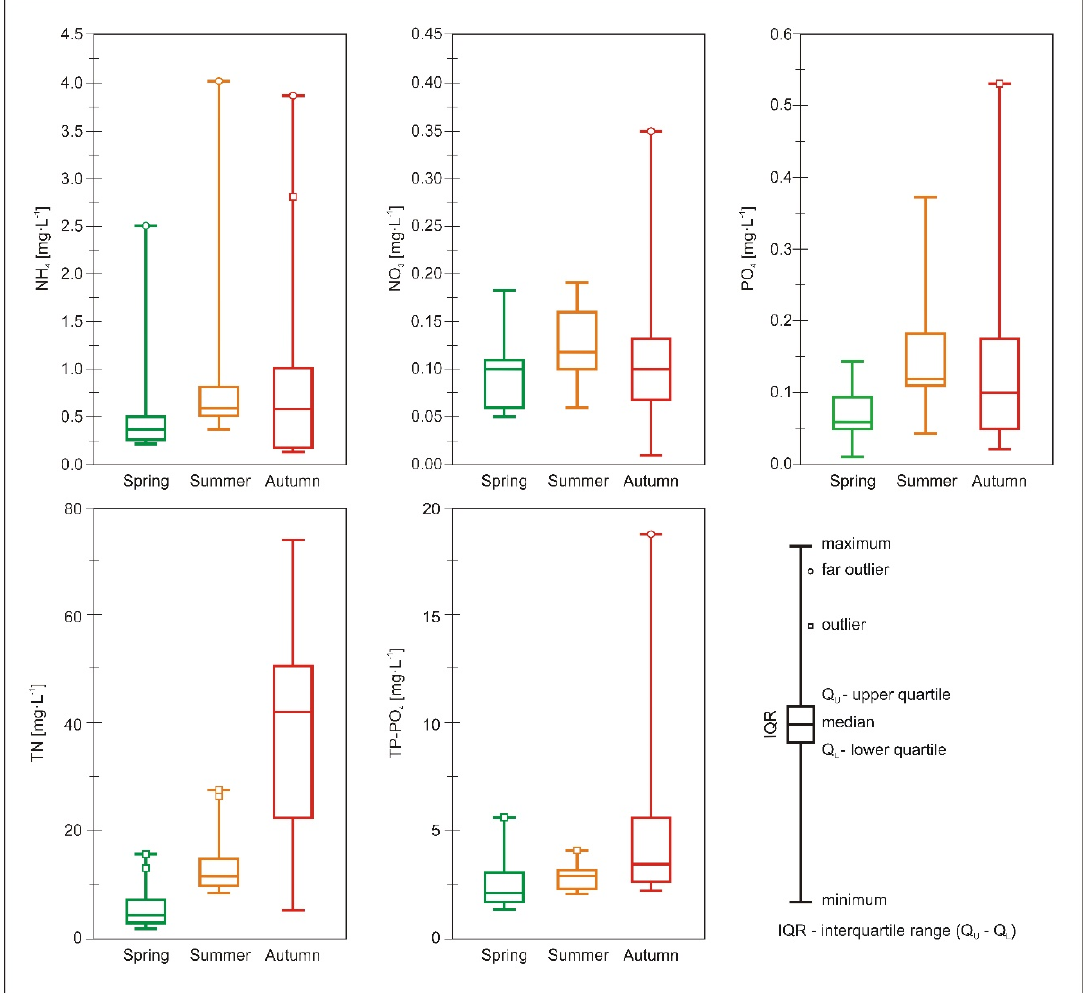
Figure 6. Seasonal changes in water quality in small floodplain reservoirs.